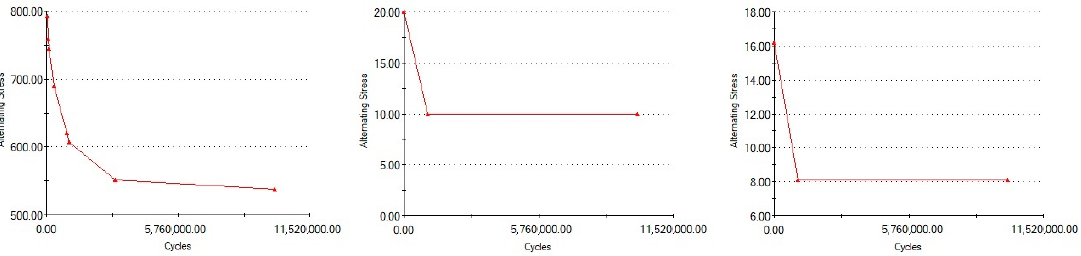
Figure 14. Wöhler curves for Grade 5 titanium (left), latex (center), Viton (right) .